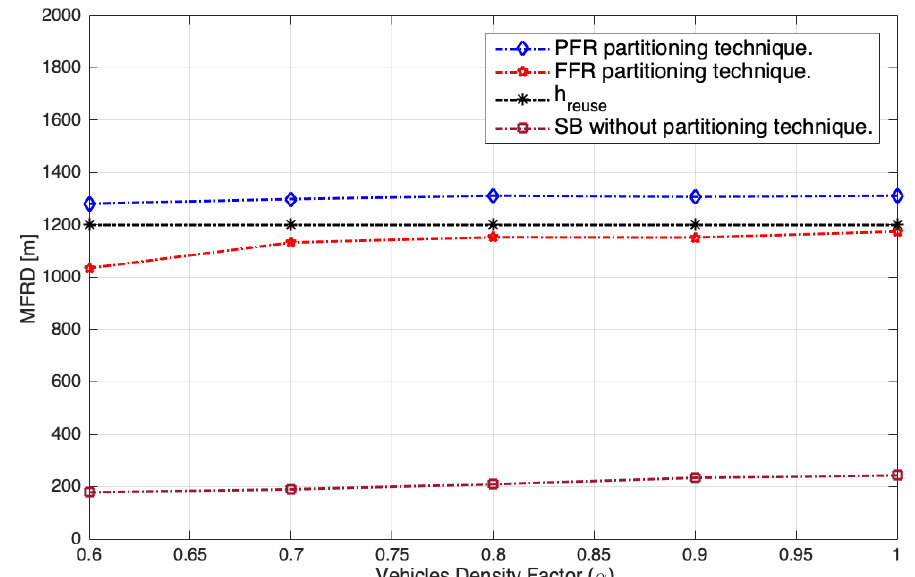
Figure 9. The Minimum Frequency Reuse Distance of CAM broadcasting messages in different vehicle density factors for both Bandwidth partitioning techniques: Full Frequency Reuse (FFR) and Partial Frequency Reuse (PFR).